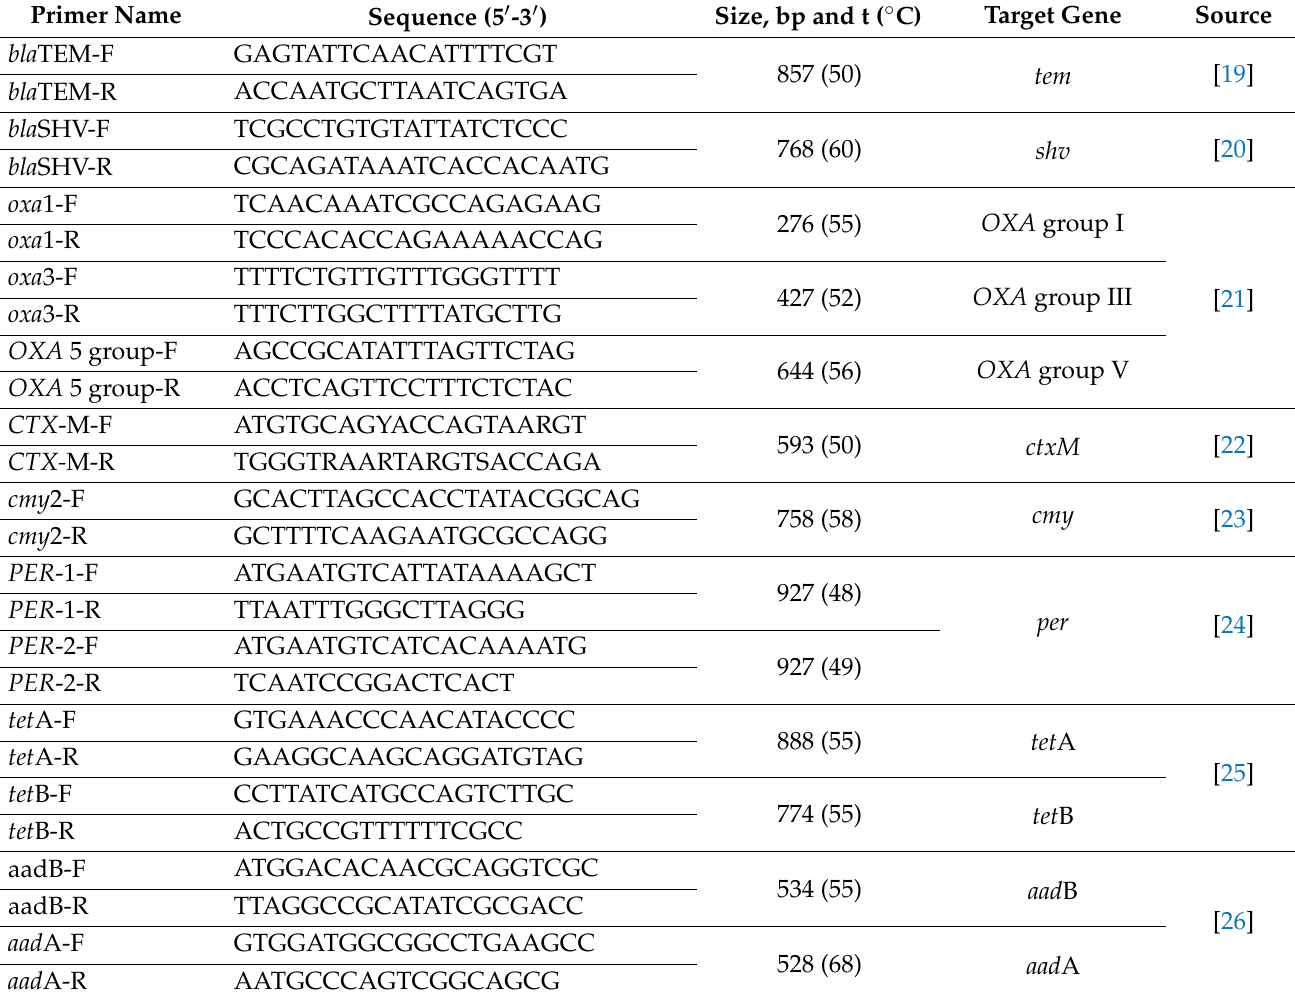
Table 2. Antimicrobial resistance genes tested and oligonucleotide primers used in the